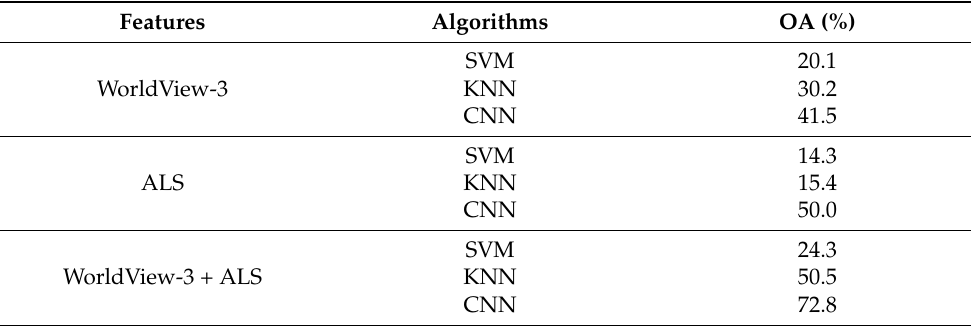
Table 5. Tree species classification performance of three machine learning